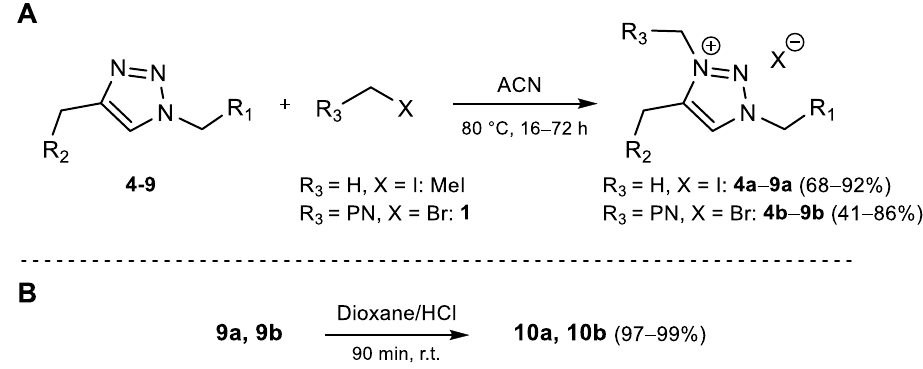
Scheme 2. Synthesis of various triazolium salts by ( A ) alkylation with MeI and 1 and ( B )